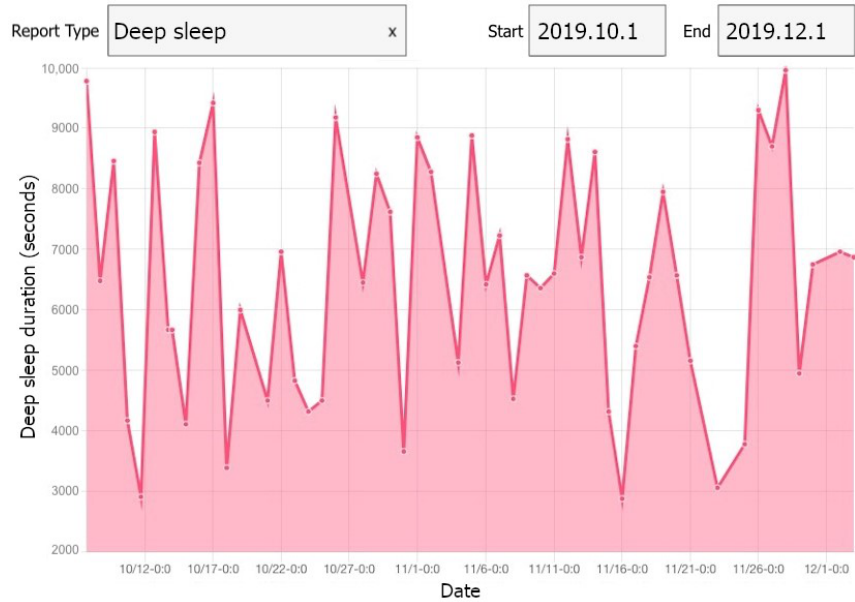
Figure 5. A view of our web application showing deep sleep of one